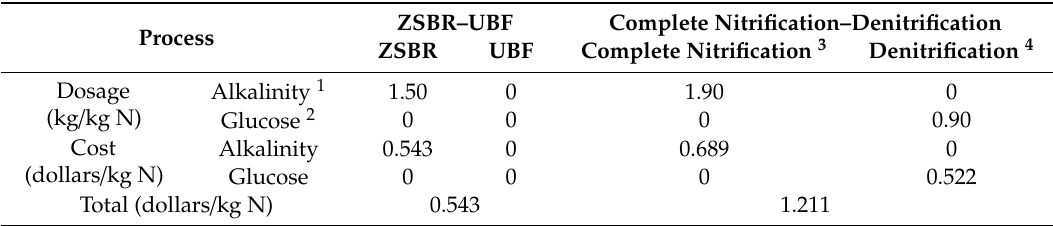
Table 4. Comparison of reagent costs between the process proposed in this study and complete nitrification and